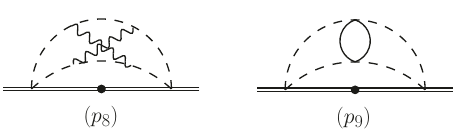
Figure 3 . non-planar corrections to the scalar bilinear two-point